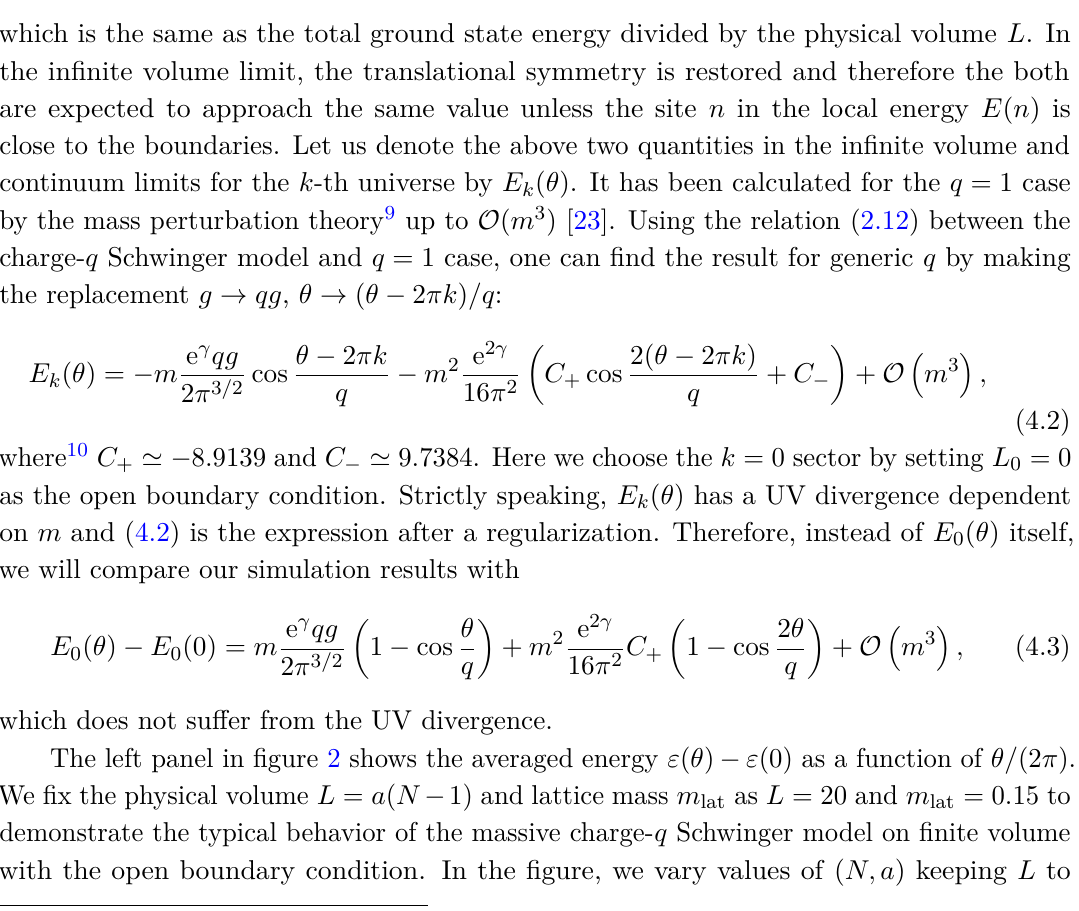
Figure 2 . Results of the averaged energy ε ( θ ) and local energy E ( n ) for the fixed physical volume L = ( N − 1) a = 20 and lattice mass m lat = 0 . 15 . (Left) The averaged energy against θ/ (2 π ) for some values of ( N, a ) . The solid curves denote the results (4.3) of the mass perturbation theory at O ( m ) (orange) and O ( m 2 ) (yellow) in the infinite volume limit. (Right) Site dependence of the local energy E ( n ) for θ/ (2 π ) = 0 and 3 π with ( N, a )=( 101 , 0 . 20